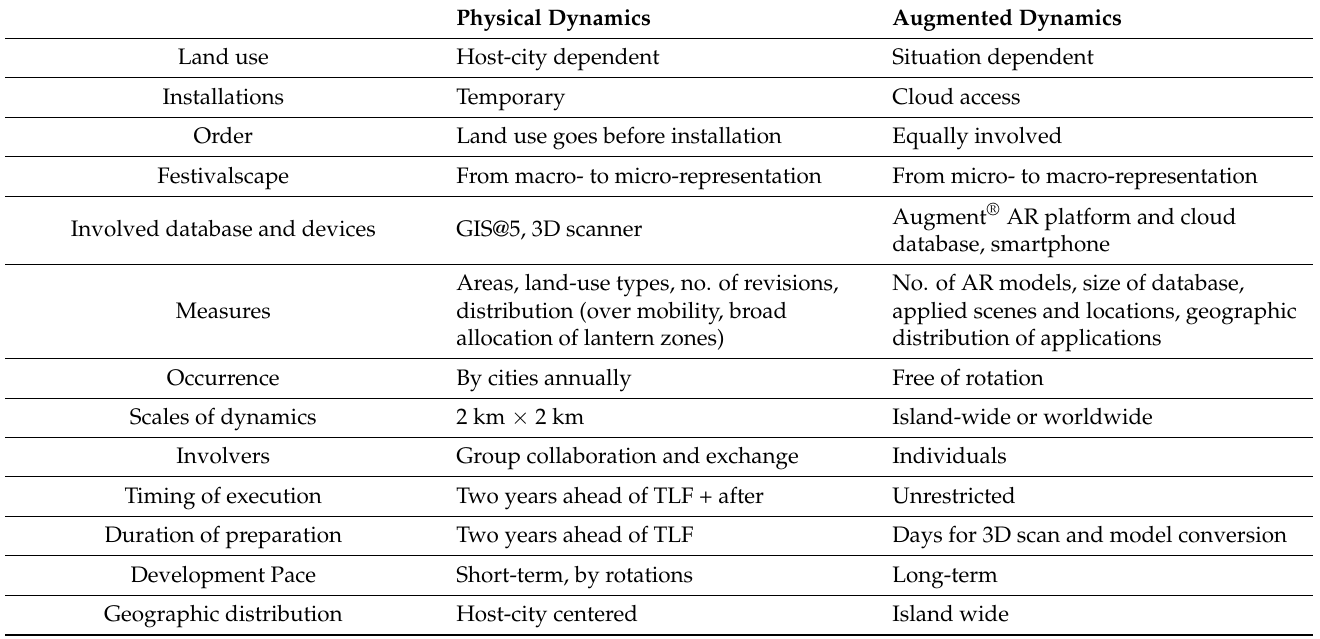
Table 2. Differentiated characteristics between physical and augmented